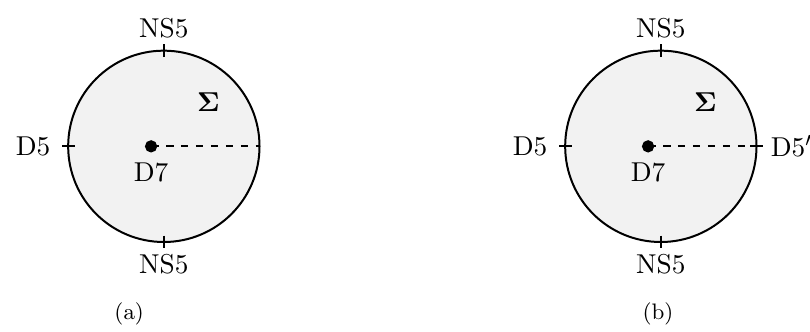
Figure 1 . On the left hand side a disc representation of the 3-pole solutions discussed in section 4.3. The D7 brane can be placed on the horizontal diameter of the disc. On the right hand side a disc representation of the 4-pole solutions discussed in section